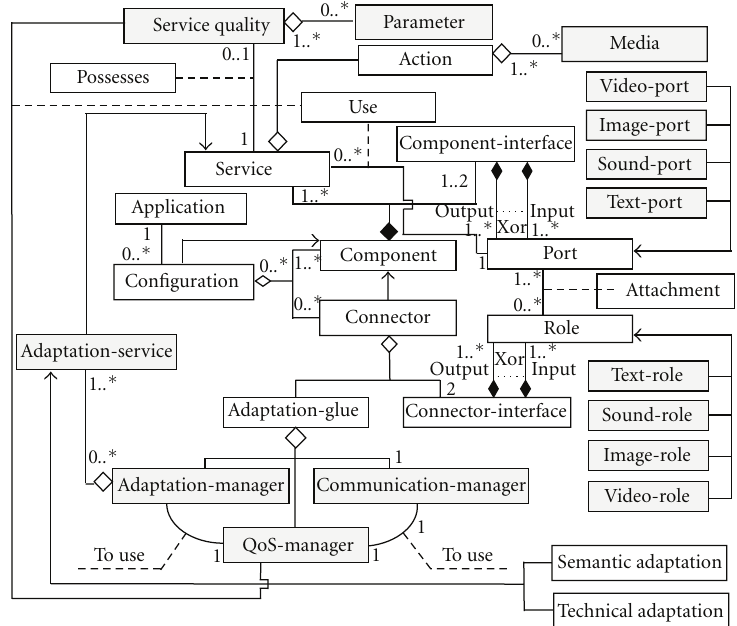
Figure 3: Class diagram of software architecture MMSA.